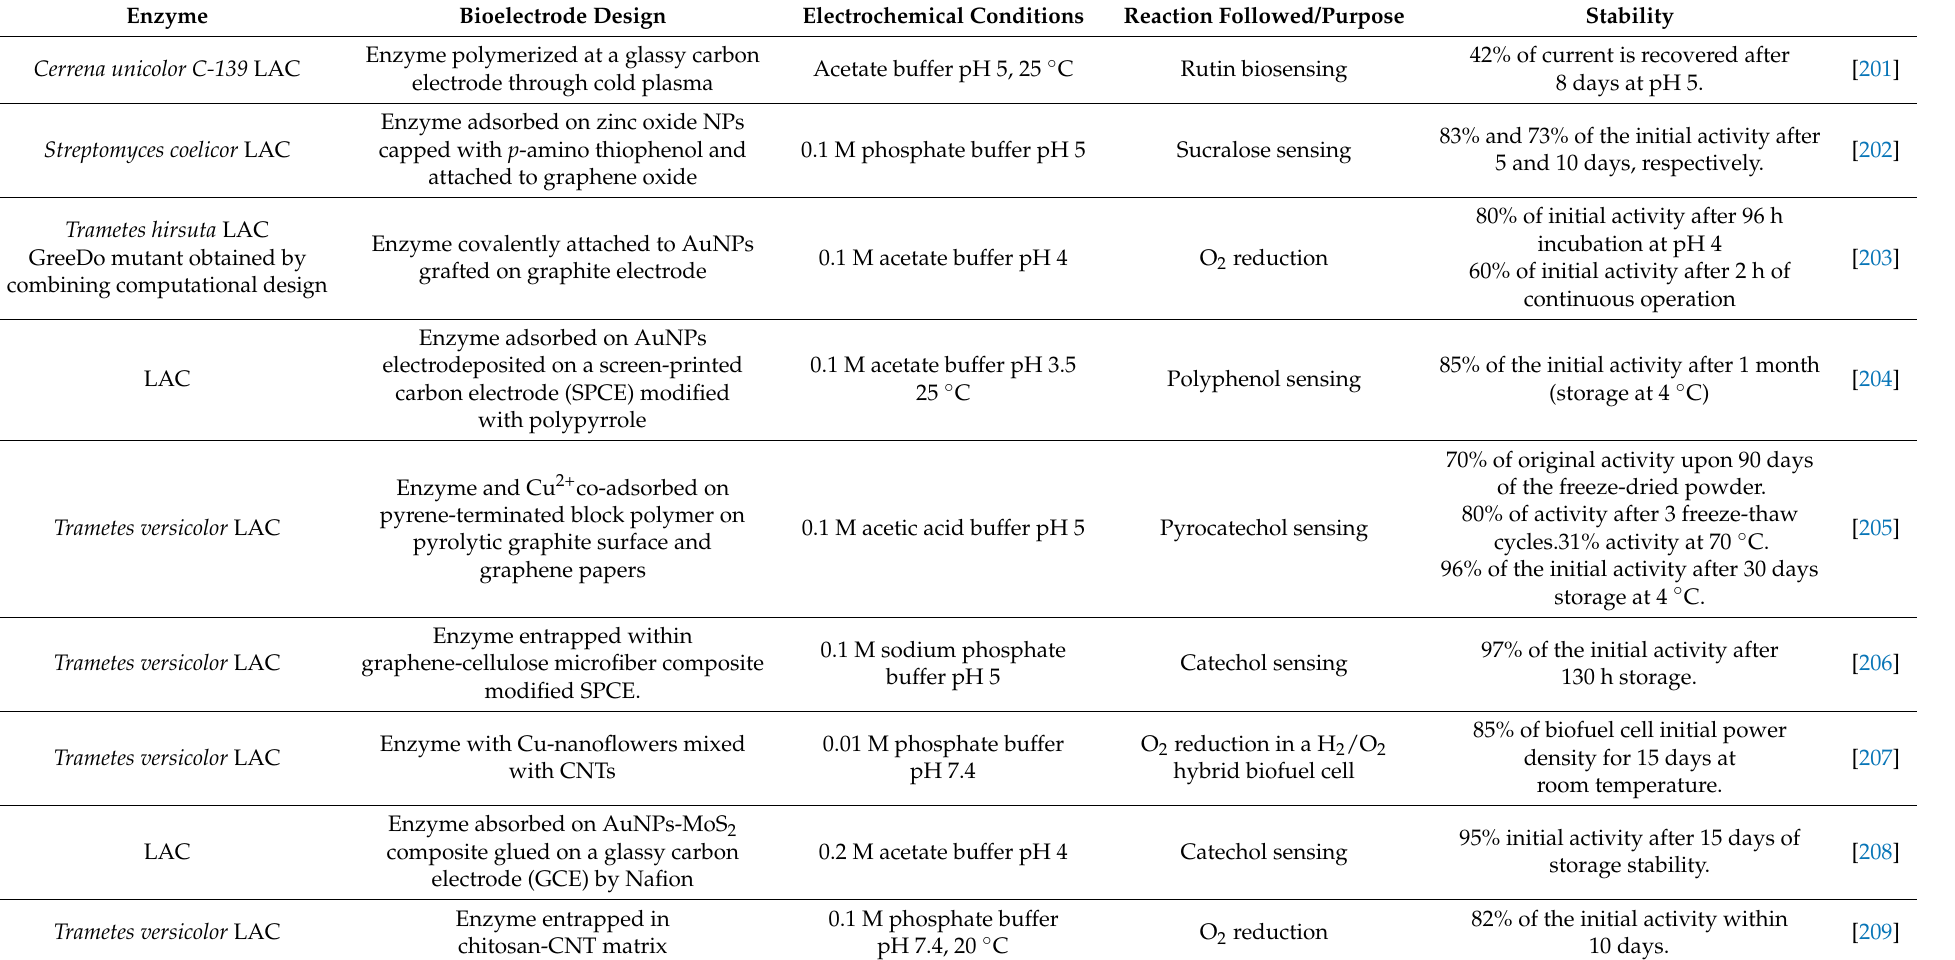
Table 1. Bioelectrode stability: cases of multicopper oxidases (MCOs) and hyperthermophilic hydrogenase